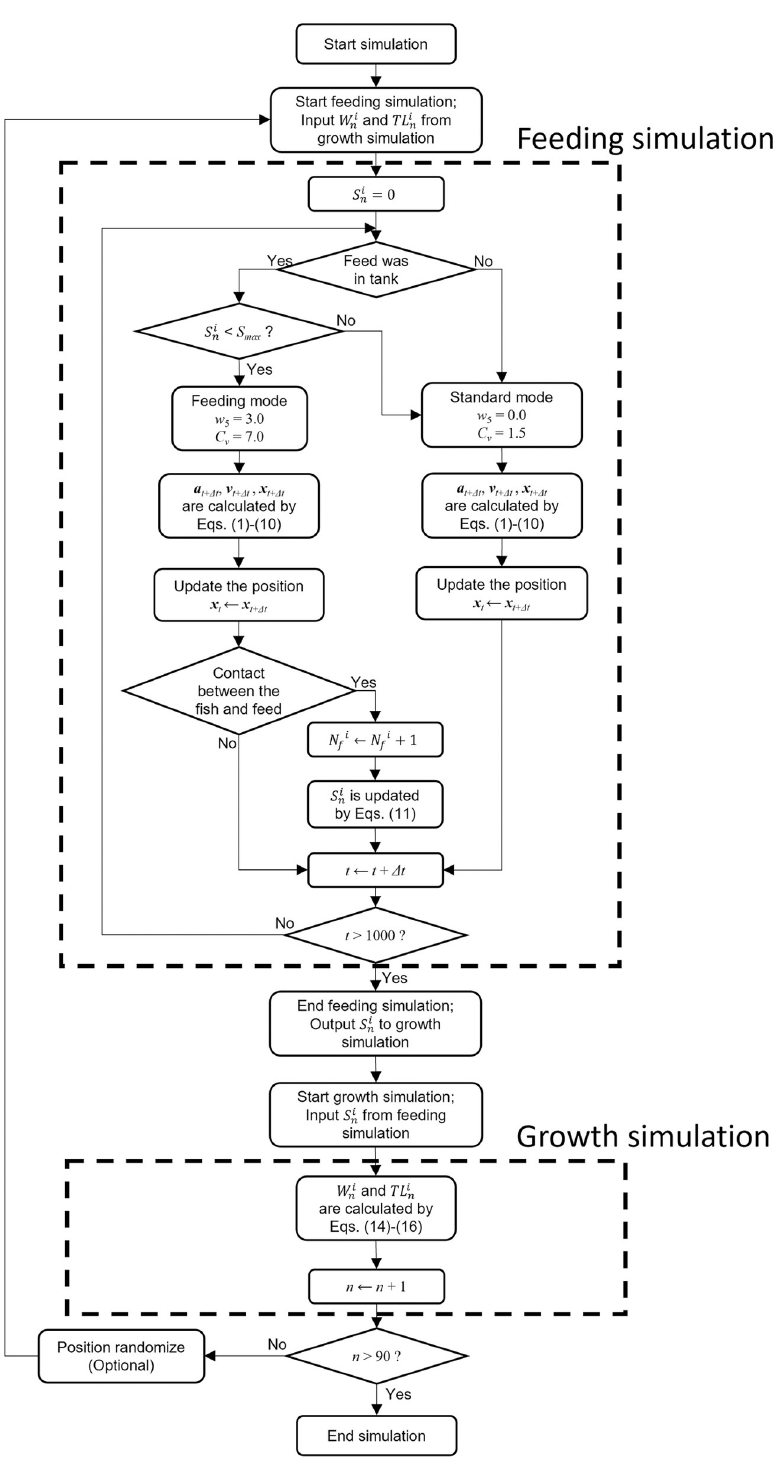
Fig 2. Flow chart of the simulation. For the feeding simulation, the input variables in the growth simulation section were W i and TL i . The feeding simulation was conducted for 1,000 s. Finally, S i n n growth simulation. The calculated S i was input into the growth simulation, which calculated W i n the values to the feeding simulation. This was repeated until the final day of the experiment (day 90). To confirm the spatial interaction between the fish and feed, a simulation in which randomization was performed every day after the feeding simulation was performed (see “Entire simulation set-up”).